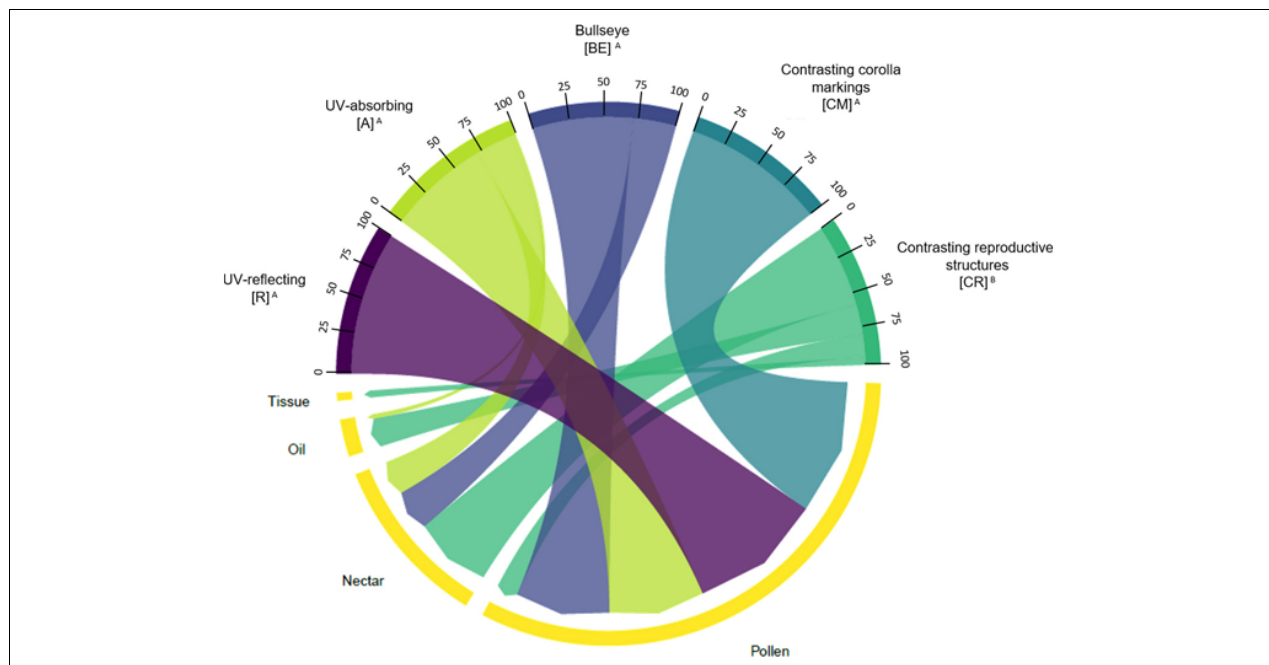
FIGURE 9 | Chord diagram showing the relationship between the types of floral UV features and the type of floral resource of 80 plant species. The chords are unidirectional. Chord thickness corresponds to the percentage of species with each UV feature that is related to a given floral resource type. Similar letters indicate that the UV categories were related to similar proportions of each floral resource type ( χ 2 = 29.278; p = 6.862 × 10 - 6 ). See Supplementary Tables 5 , 6 for percentages and detailed statistics. R, non-patterned UV-reflecting; A, non-patterned UV-absorbing; BE, bullseye; CM, contrasting corolla markings oriented towards floral resources; CR, contrasting reproductive